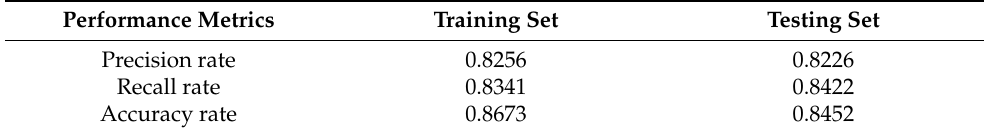
Table 5. Performance metrics of the CSA-ELM model.